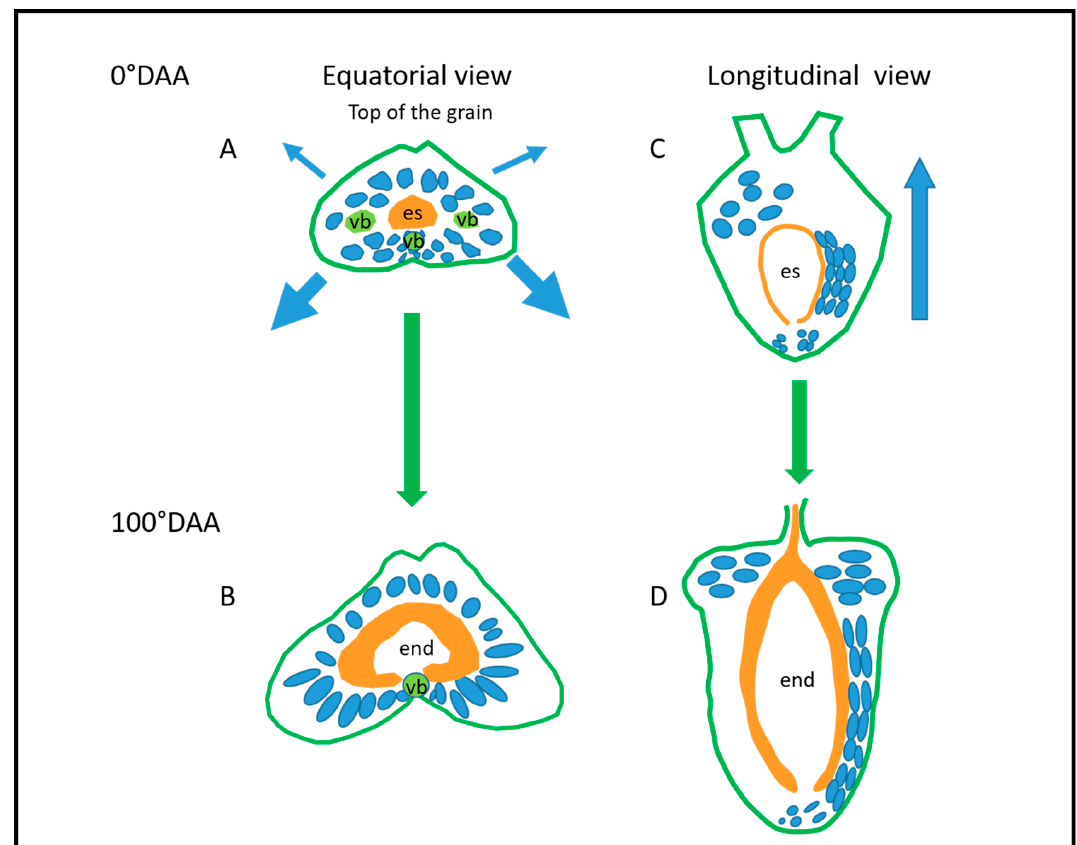
Figure 13. Schematic model of the main elongation axis of mesocarp cells related to the caryopsis growth. Mesocarp cells are represented in blue. This role is illustrated between the development stages 0 ( A , C ) and 100 °DAA ( B , D ) in two views: ( A , B ) equatorial and ( C , D ) longitudinal. Blue arrows indicate the main direction of caryopsis growth giving the orientation of mesocarp cells.